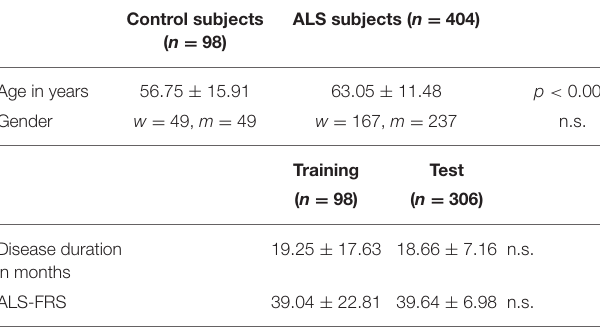
TABLE 1 | Demographic and clinical features of the